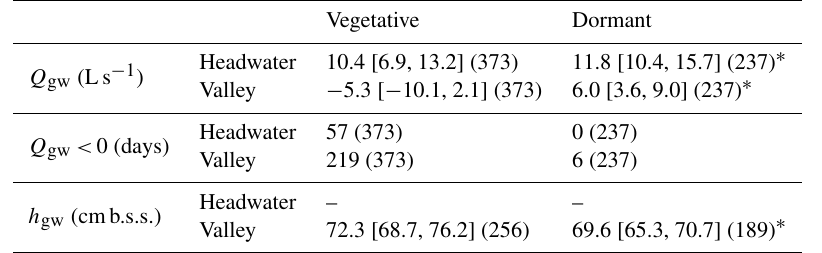
Table 2. Net groundwater inputs to stream discharge ( Q gw ), number of days with stream hydrological retention ( Q gw < 0) and groundwater depth ( h gw ) for the vegetative and dormant period, respectively. The number of cases is shown in parentheses for each group. For Q gw and h gw , data are shown as median ± interquartile range [25th, 75th], and the asterisks indicate statistically significant differences between the two periods (Wilcoxon rank sum test, ∗ p < 0.01).